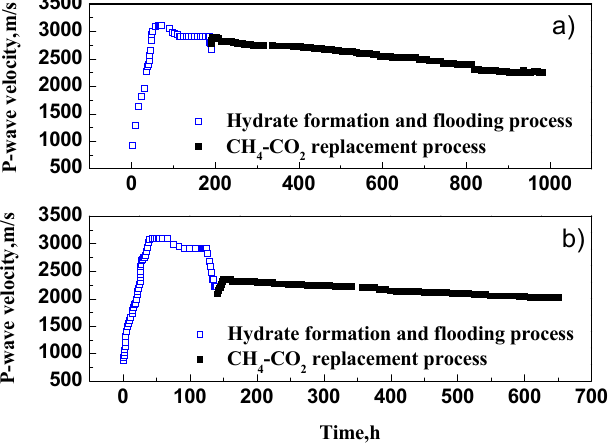
Figure 3. Variation of P-wave velocity with elapsed time during methane hydrate formation and CH -CO replacement processes. ( a ) Run1 at 273.2 K and ( b ) run 2 at 277.2 4 2